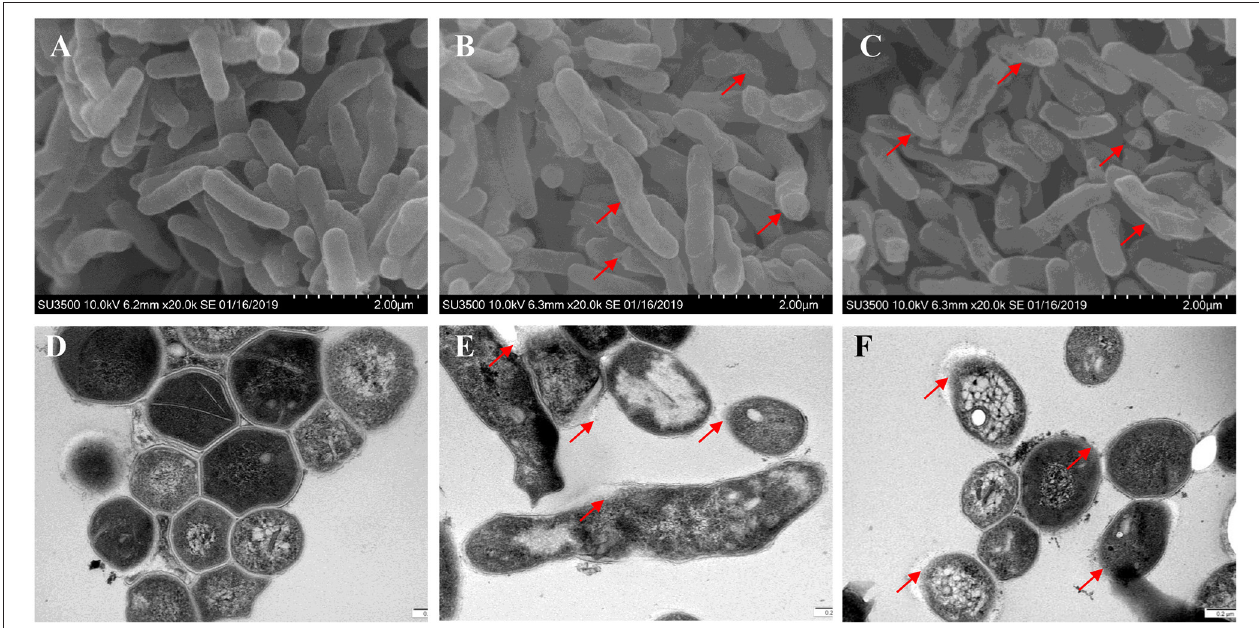
FIGURE 4 | Scanning electron microscopy and transmission electron micrographs of Mtb H37Ra cells. SEM of untreated cells of Mtb H37Ra (A) and Mtb H37Ra treated with TPSA (2 × MIC) for 24h (B,C) (20,000 × ). Red arrows in (B,C) depict the unsmooth and wrinkled surface of bacilli. TEM of untreated cells of Mtb H37Ra